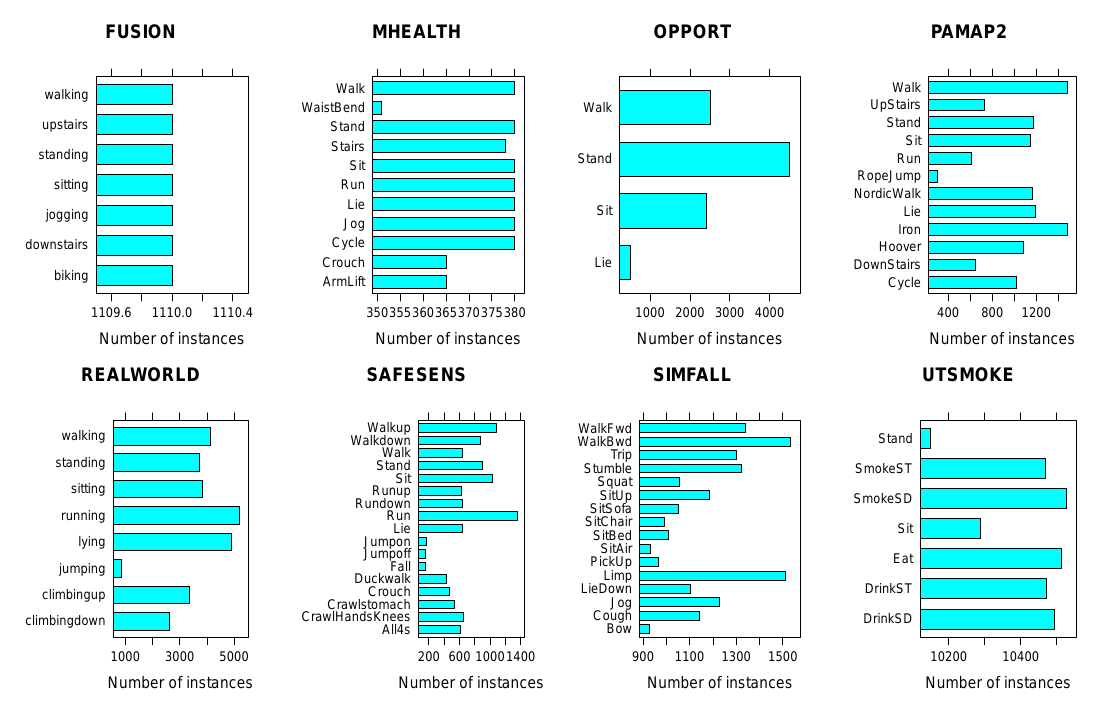
Figure 1. Number of instances per activity for each